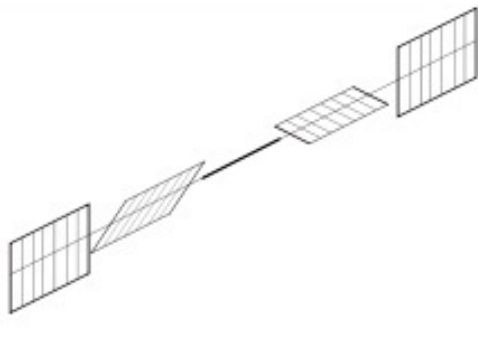
Figure 5. Torsion along a